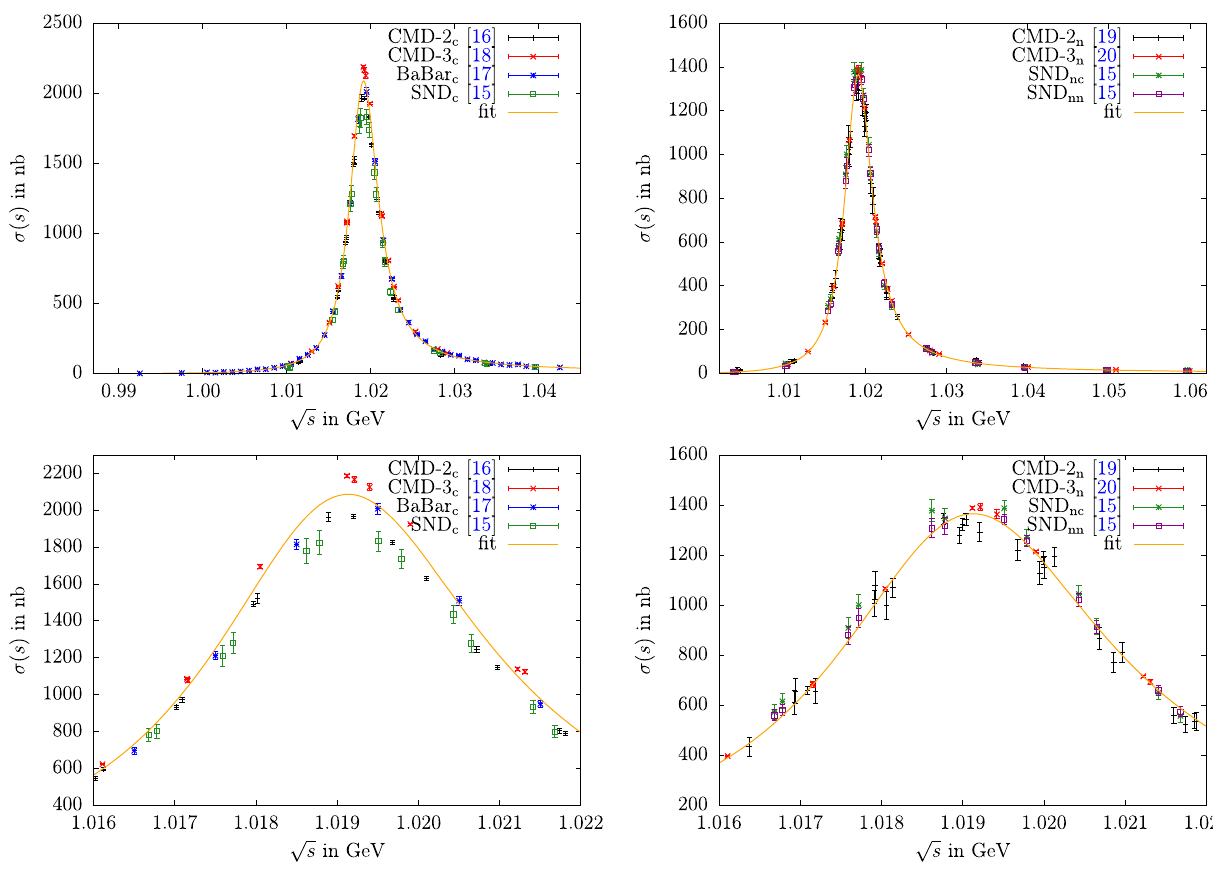
complete fit energy ranges (top) and focused on the φ peak region (bot- tom). The fits of charged and neutral channels are indistinguishable from the “fit” curves shown